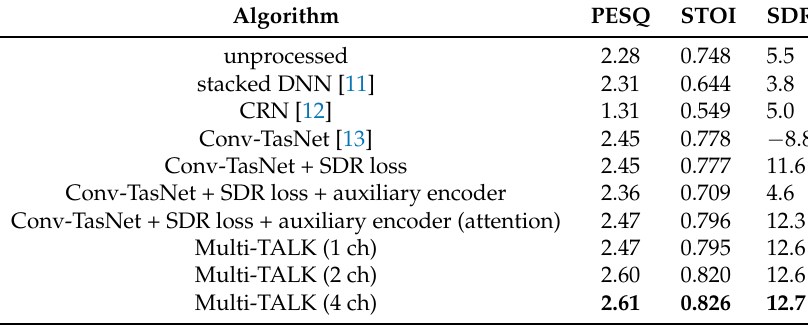
Table 3. Average PESQ, STOI, and SDR for the near-end single-talk